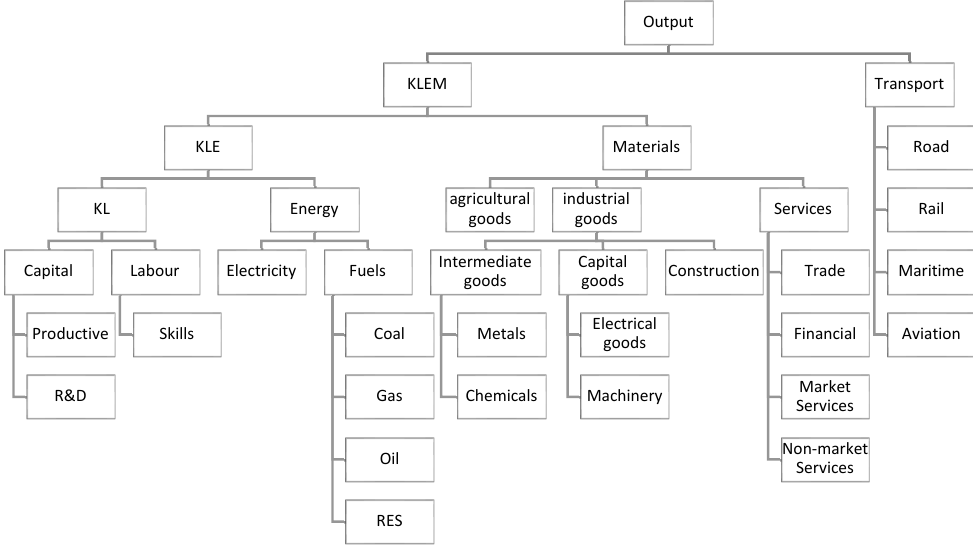
Figure 1. Schematic representation of the GEM-E3-R nesting schemes for industrial sectors.